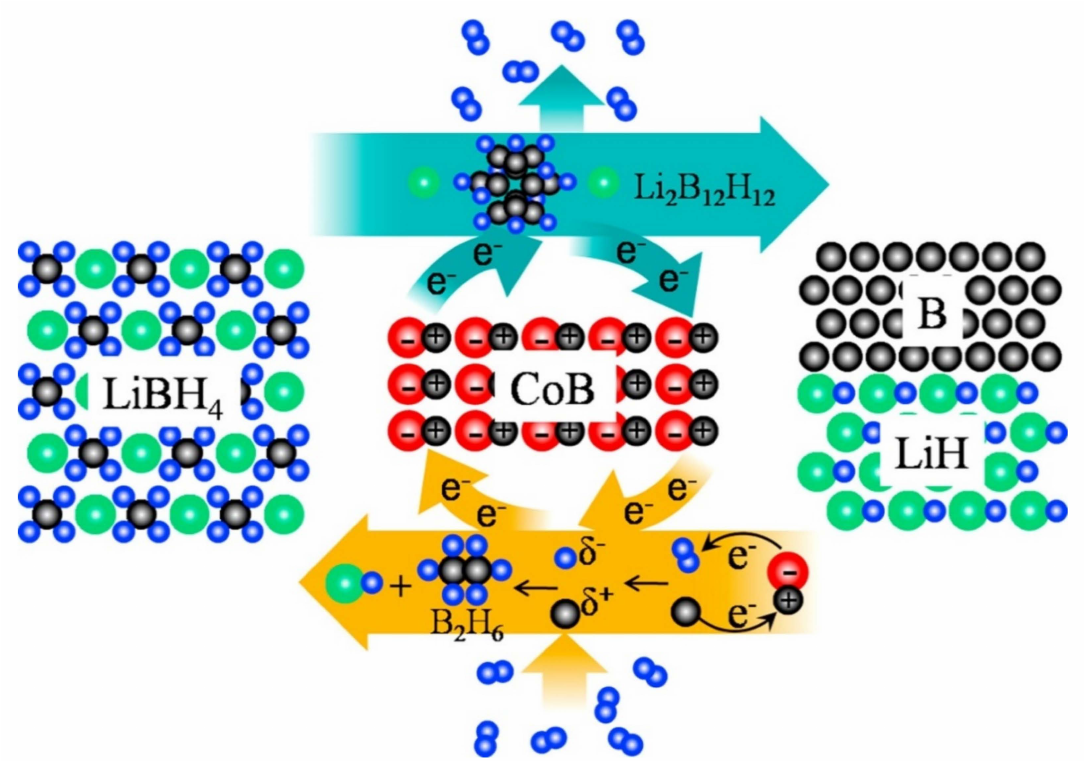
Figure 15. Schematic illustration of dehydrogenation and rehydrogenation mechanism of CoB-catalyzed LiBH 4 [125]. (Reprinted with permission from